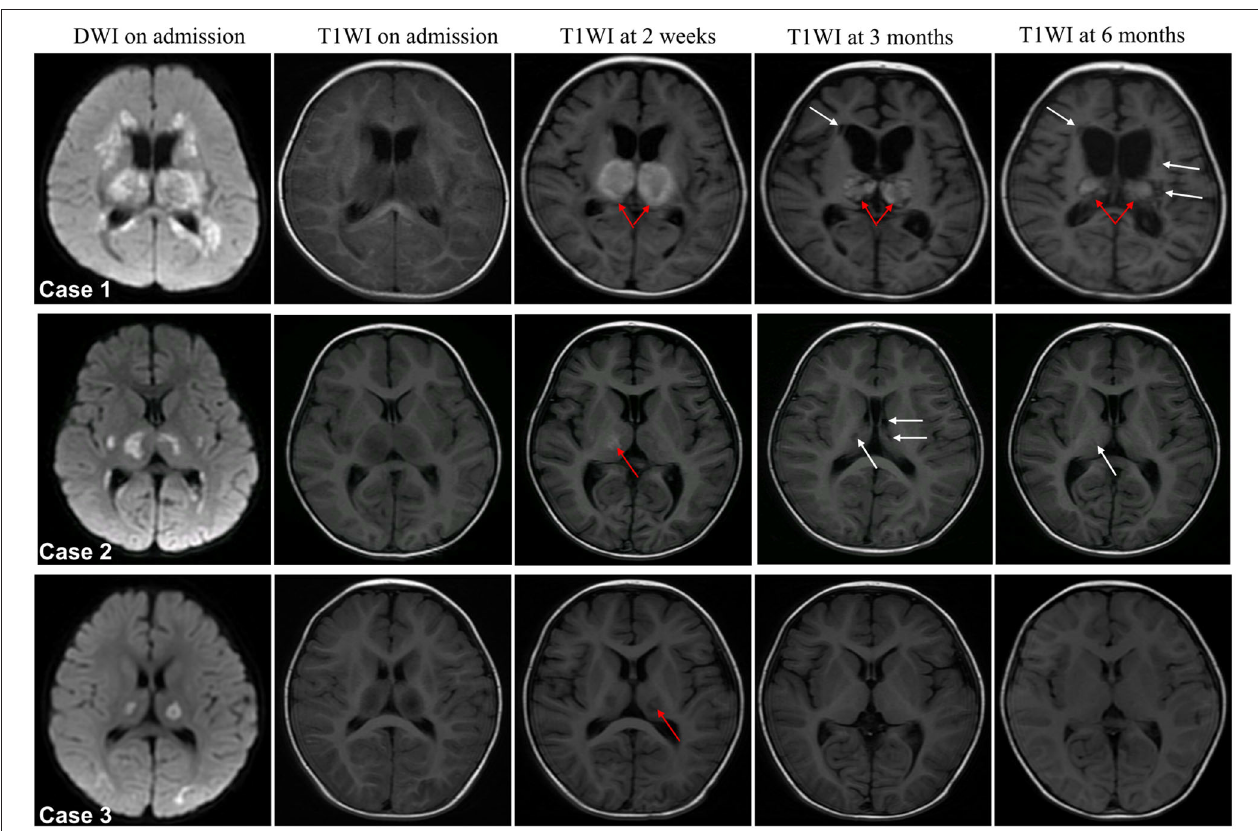
FIGURE 4 | Representative dynamic MRI images of survival ANE patients with different degrees of neurological sequelae. Case 1 with severe, case 2 with moderate and case 3 with mild neurological sequelae. Arrow in red indicates hemorrhage and white indicates